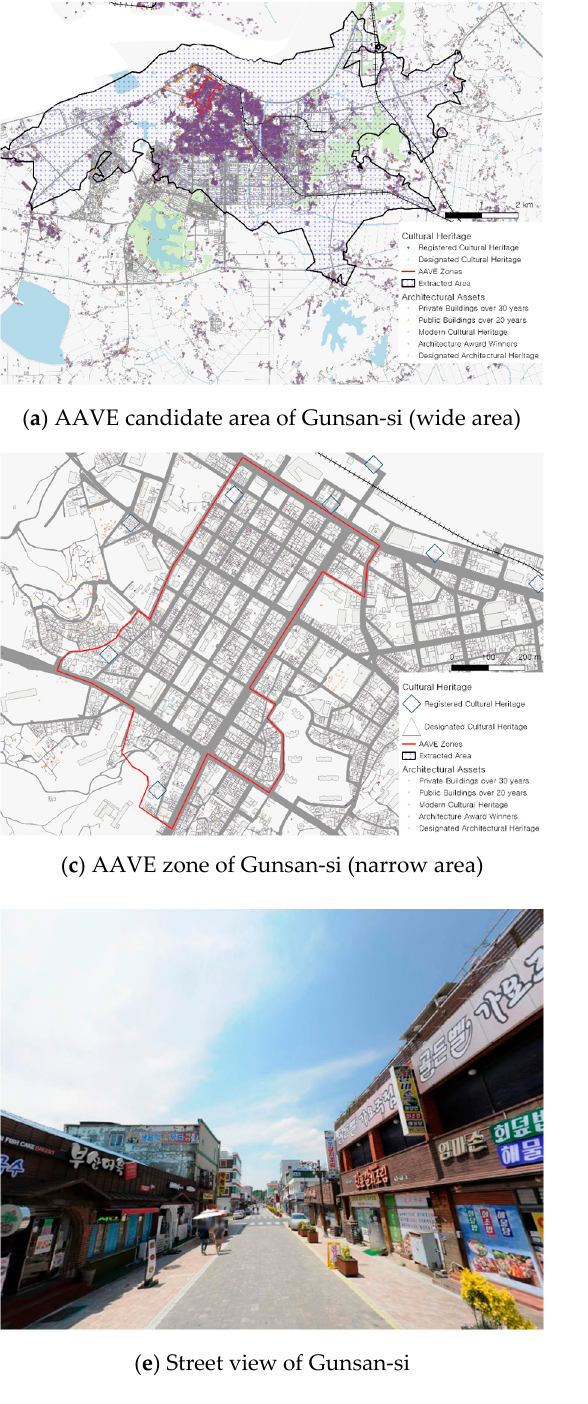
Figure 7. Comparison of derived results with existing AAVE zones (left, Gunsan-si; right, Daegu city).